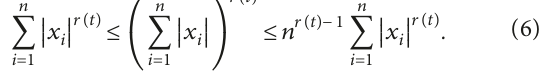
Figure 2: Sketch of the networked control system for plant